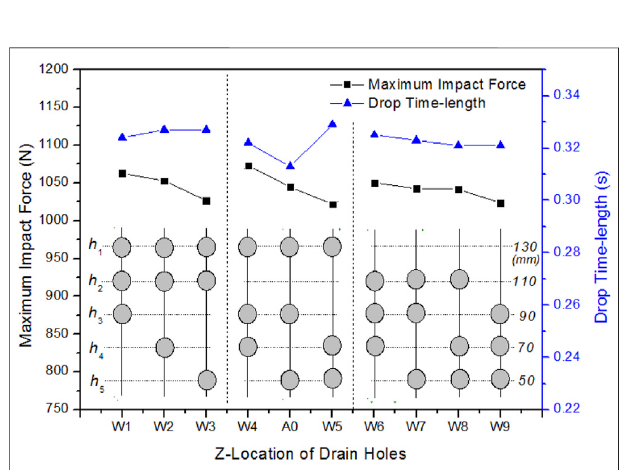
FIGURE 7 | The effects of piston stroke on the real-time impact force.